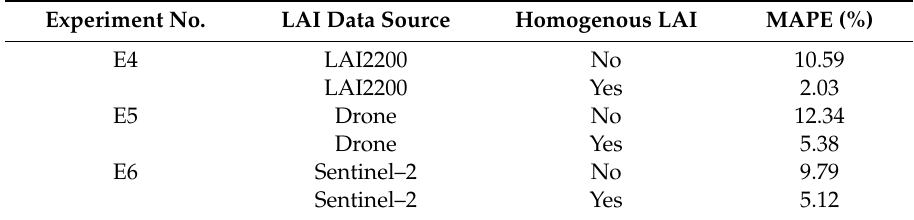
Table 3. Performance of SIMRIW–RS based on dekadal satellite weather-related products. Experiment No.